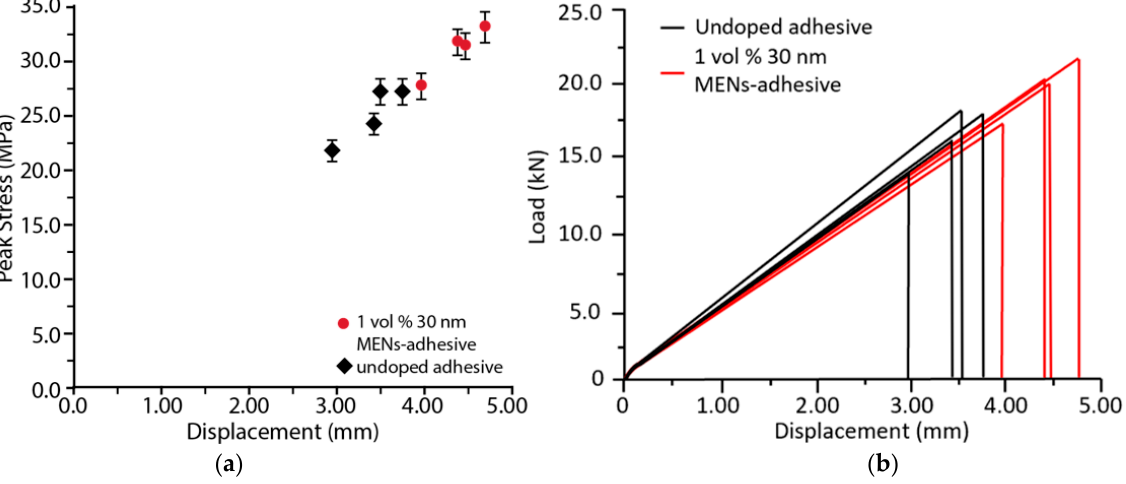
Figure 6. ( a ) Peak stress of undoped and doped adhesives for single lap shear samples; ( b ) load– displacement curves for undoped (black) and doped (red) samples. displacement curves for undoped (black) and doped (red) samples.